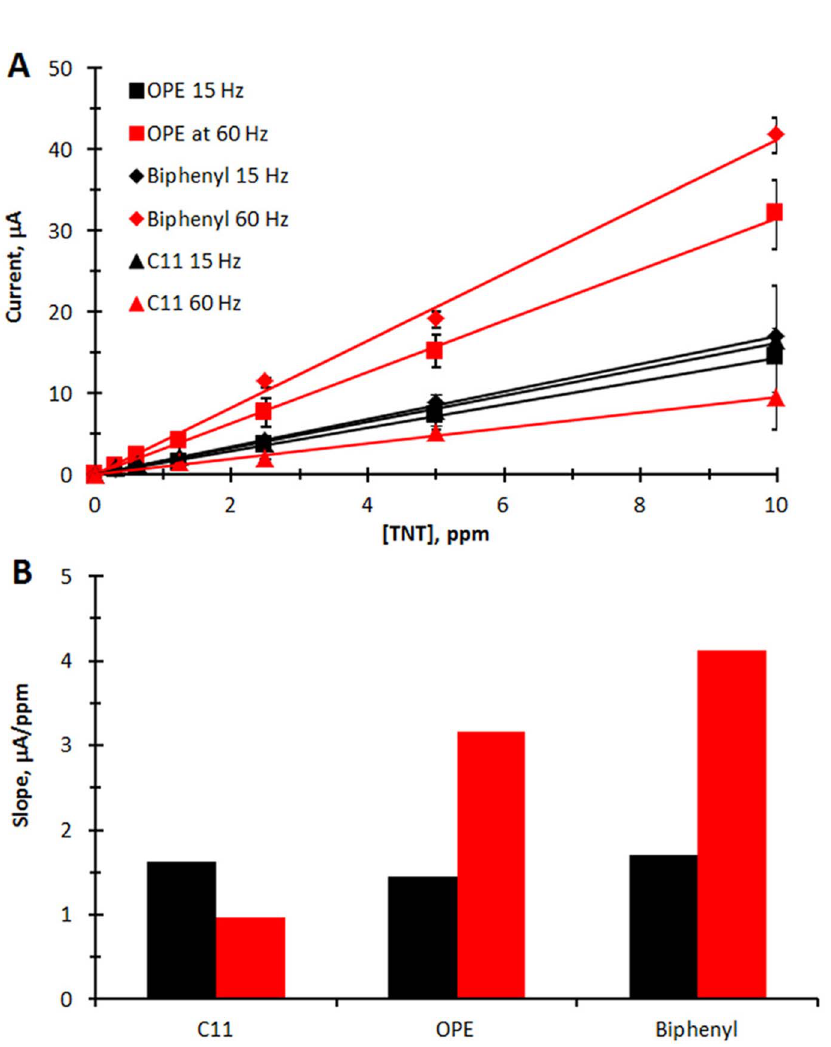
Fig. 3. Characteristics of electrochemical detection of TNT. A. Background subtracted peak current vs. [TNT] measured at the first reduction of TNT from the corresponding square wave voltammograms (average of two electrodes). B Slope ( m A/ppm) of the calibration curves vs. SAM type and Hz. Black 5 15 Hz, Red 5 60